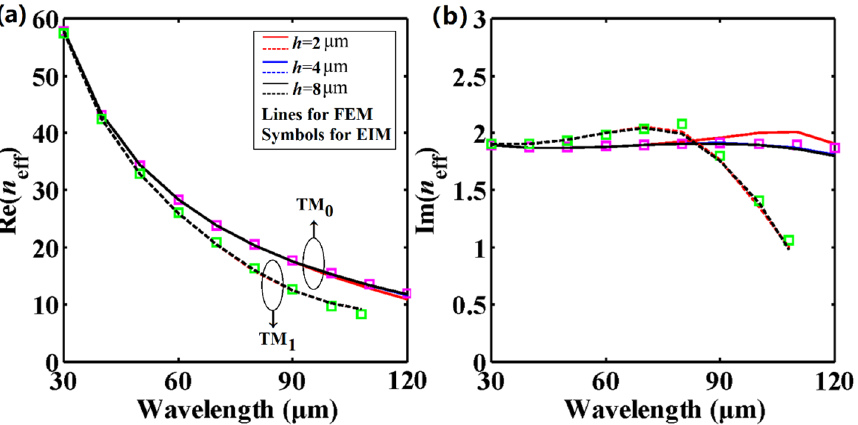
Figure 5. ( a ) Real and ( b ) imaginary parts of the effective mode indices of the TM 0 and TM 1 modes in DLGSPWG with respect to the wavelength at different strip heights. w = 4 μ m, E F = 0.6 eV. Note that the blue and black lines nearly overlap each other. Solid lines and pink squares for TM 0 , dashed lines and green squares for TM 1 .